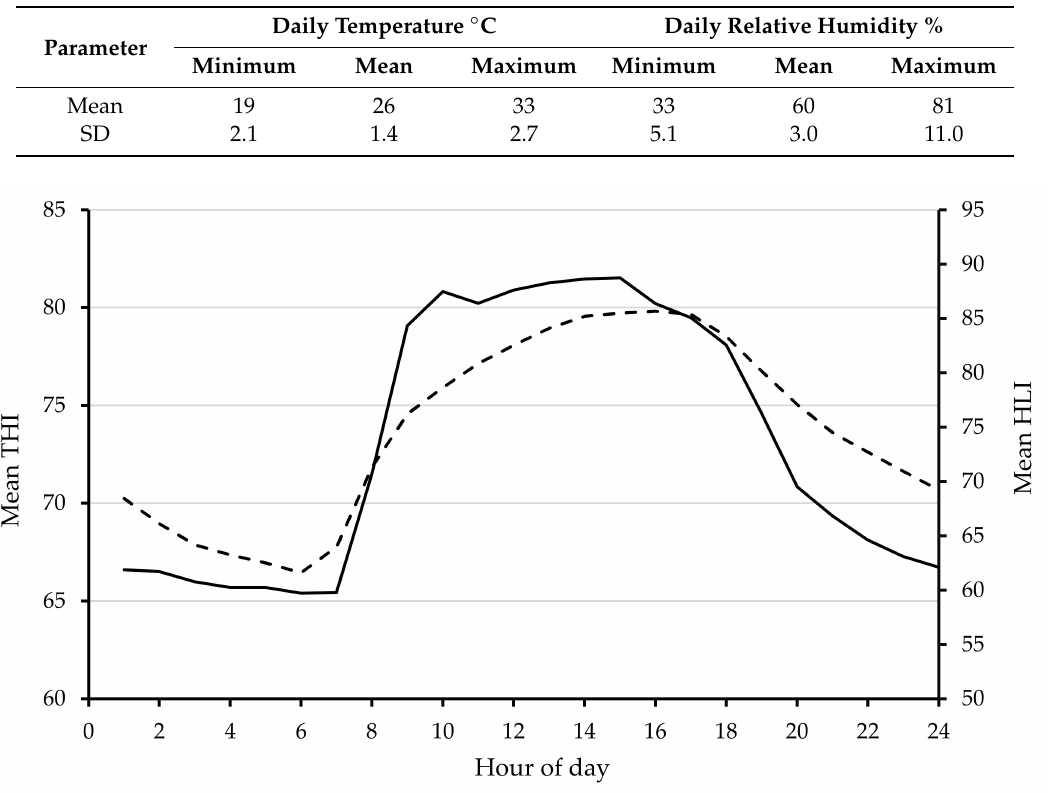
Figure 2. Mean hourly temperature humidity index (THI) ( broken line ) and heat load index (HLI) ( solid line ) values across 24 h for Experiment